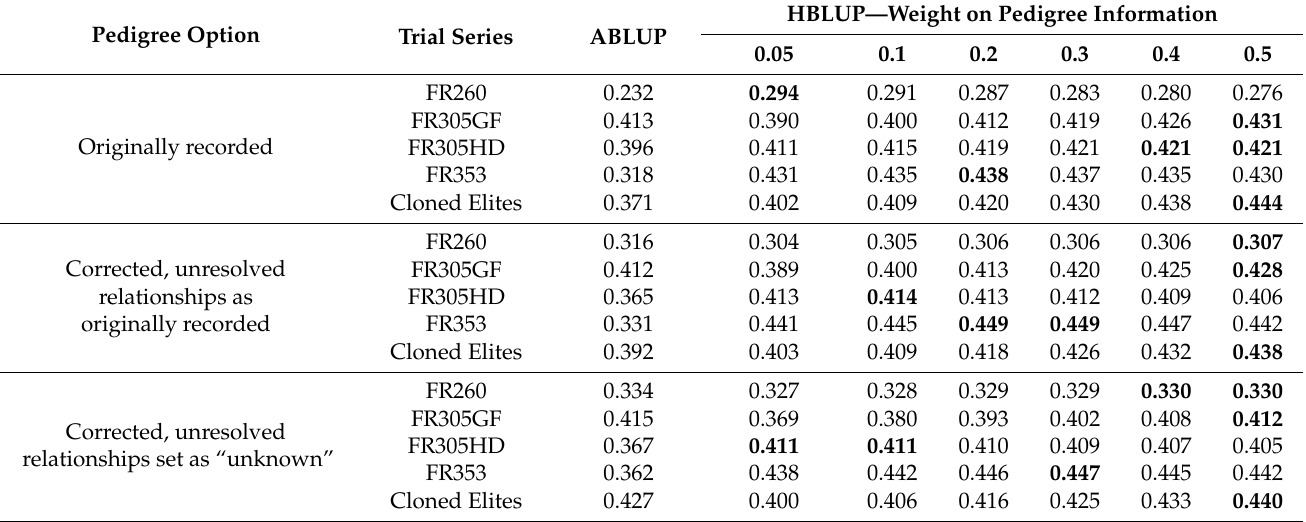
Table 4. Predictive abilities for pedigree-based (ABLUP) versus single-step blended (HBLUP) pre- diction analyses for wood density (WD). Results from the best HBLUP model are shown in bold. Cross-validations were performed by including all but one trial series in the training set, with the remaining trial series used as a test set (see Materials and